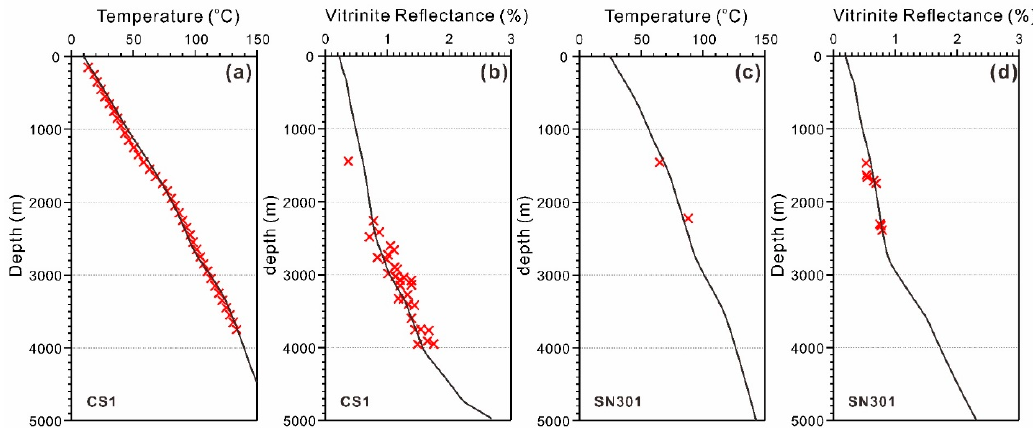
Figure 13. Validation of the simulation results. The temperature and vitrinite-reflectance measurement data (red cross) and simulation results of wells CS1 ( a , b ) and SN301 ( c , d ) showed good fit.